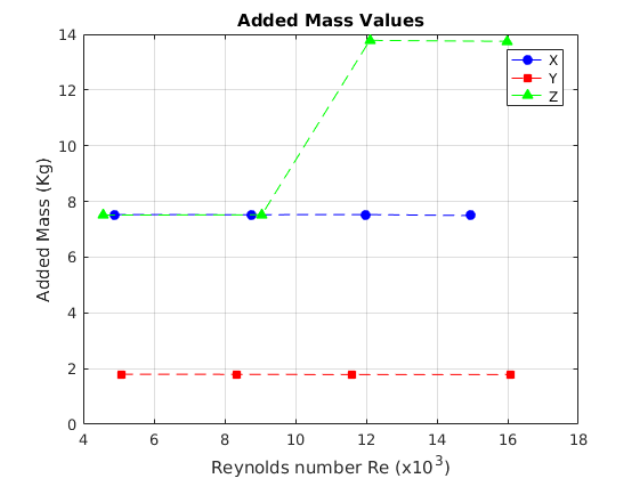
Figure 17. Behaviour of the added mass. The values for each axis are similar at all